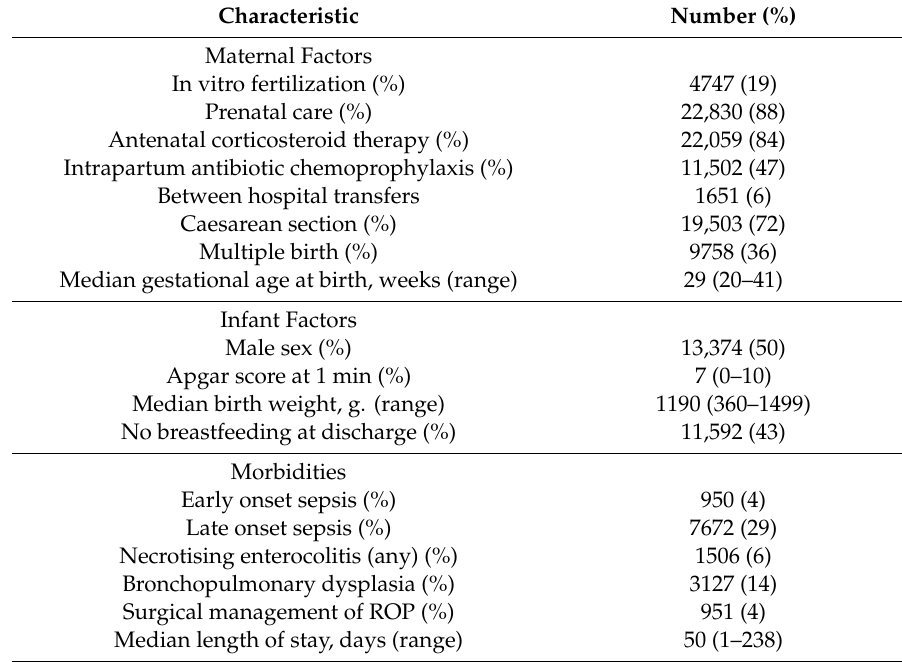
Table 1. Characteristics of 26,957 VLBW infants discharged alive from 62 Spanish neonatal units in